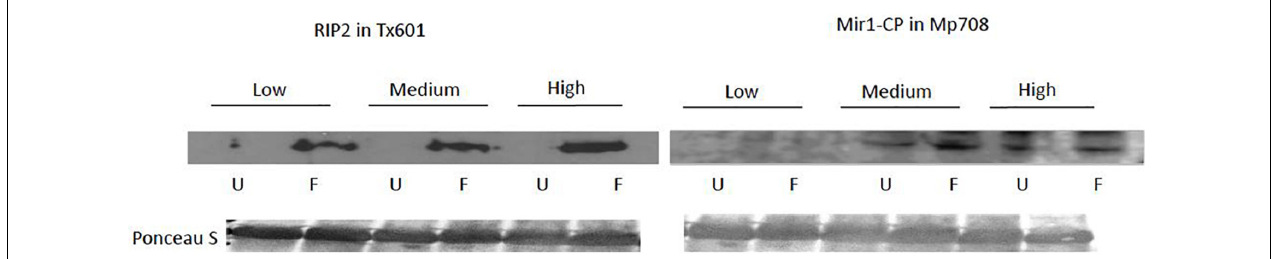
FIGURE 3 | Influence of herbivory and fertilization on the protein levels of RIP2 and MIR1-CP in Tx601 and Mp708, respectively. Immunoblot detection of defense related proteins RIP2 and MIR1-CP was performed in Tx601 and Mp708, respectively, for plants with low, medium and high regimens of fertilizer. Within each fertilizer treatments, plants were either left undamaged (U) or fed with 5 th instar fall armyworm larva for 24hrs (F). Each well represents 50 µ g of total protein that was pooled from equal amounts of protein from six plants, equal loading and transfer is shown in Ponceau S stain of the blots.